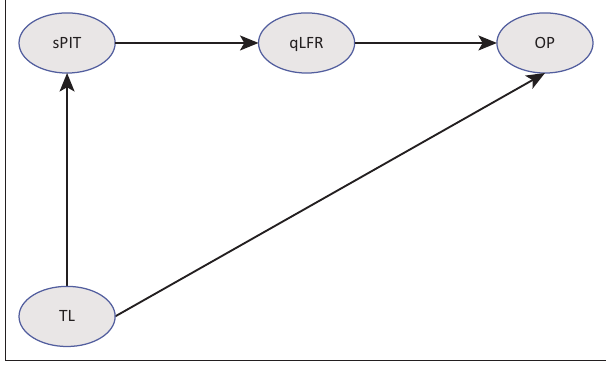
FIGURE 2: Final model .